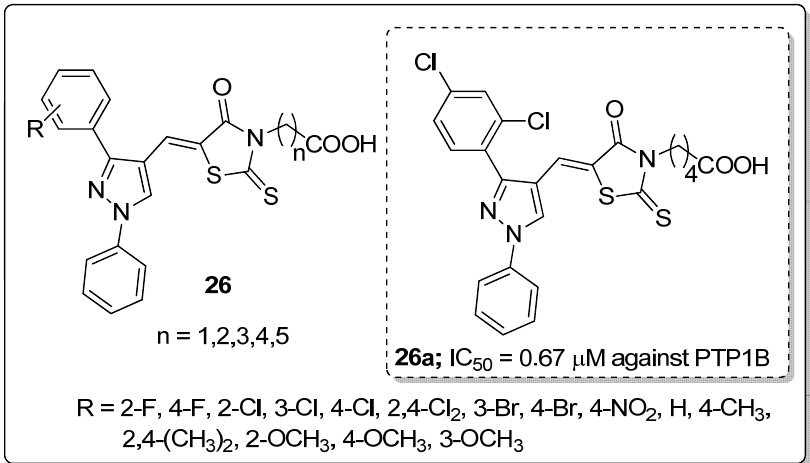
Figure 30. PTP1B inhibitory activity of most active pyrazole conjugate 26a .